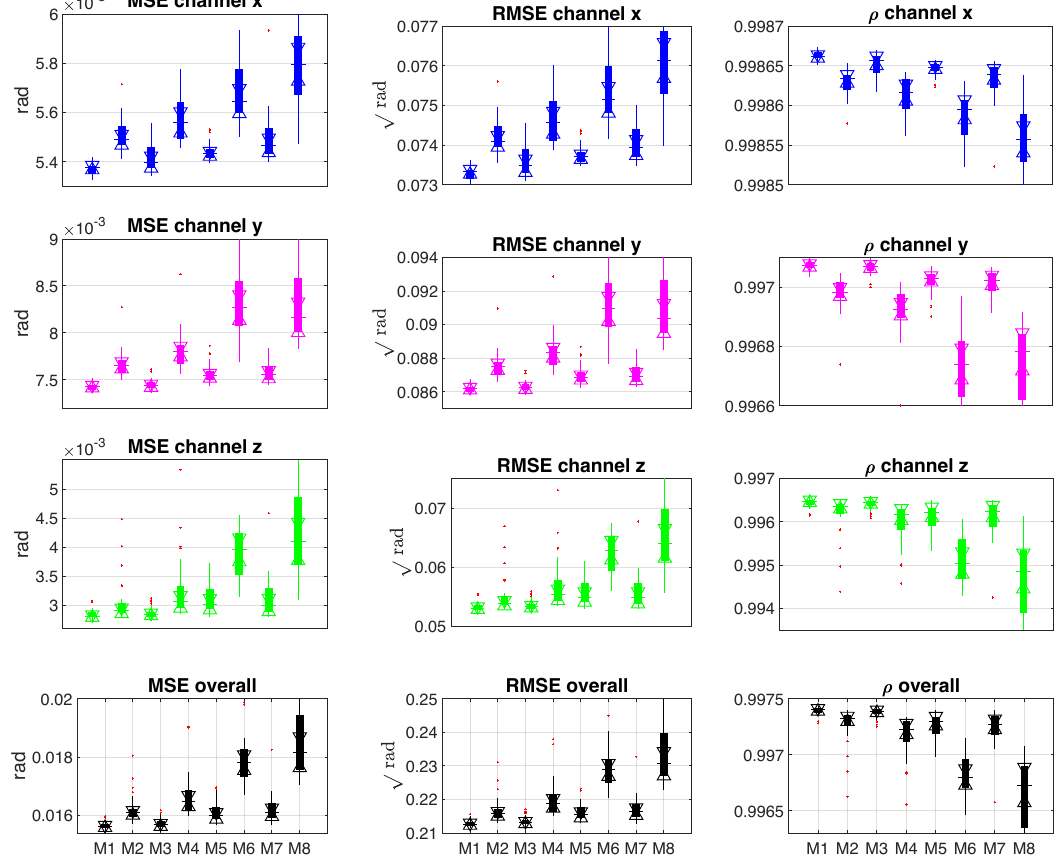
Figure 9. The comparison results of mean square error (MSE), root mean square error (RMSE) and correlation coefficient ρ among models M1–M8 on the training dataset. Table 3. The comparison of training time among the eight models (M1–M8) in Table